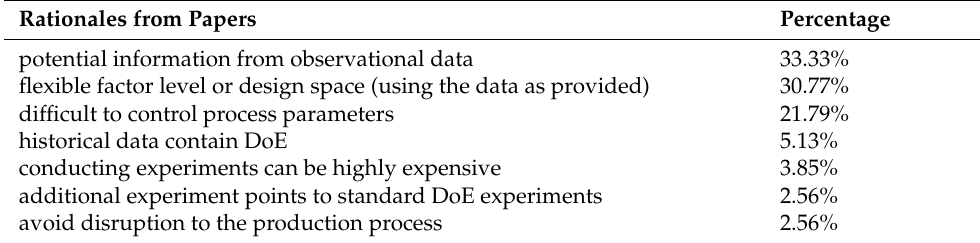
Table 4. Rationales for selecting